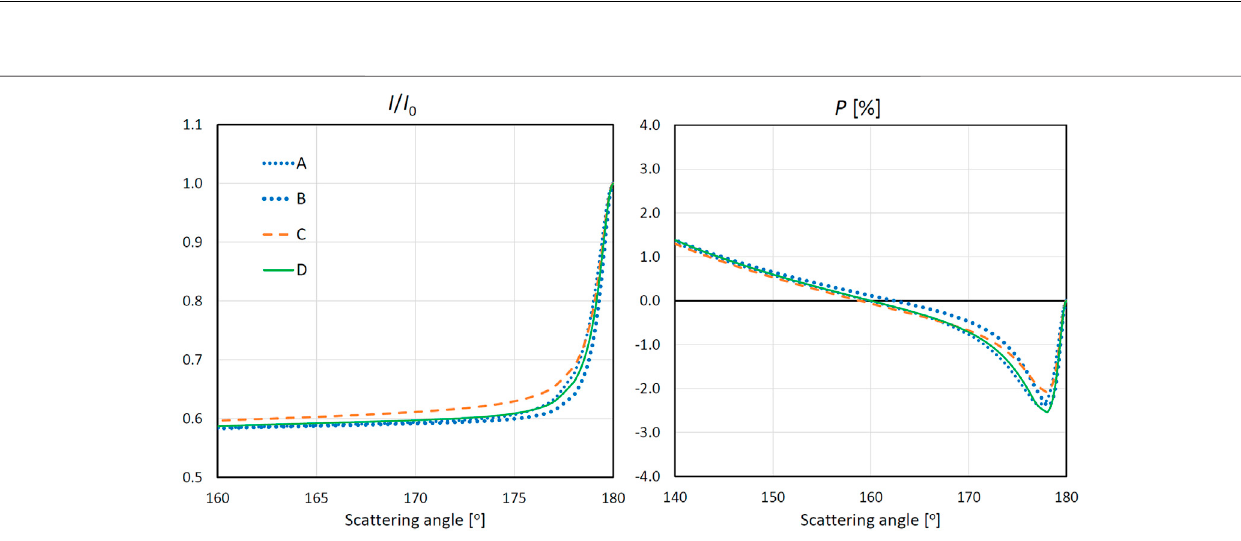
Frontiers in Remote Sensing |